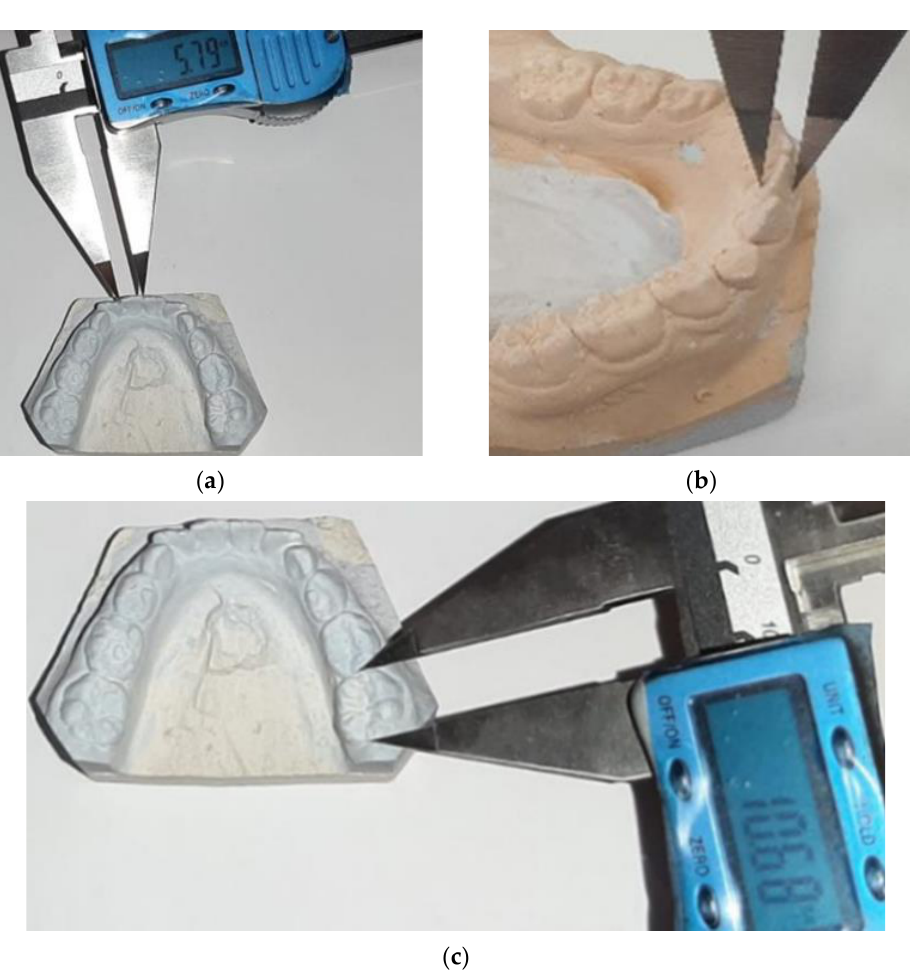
Figure 3. Procedures of measuring mesio-distal widths of permanent teeth exemplified through lower left central incisor ( a ), bucco-lingual dimensions exemplified through lower right central incisor ( b ), and mesio-distal widths of permanent teeth exemplified through lower right first permanent molar ( c ).